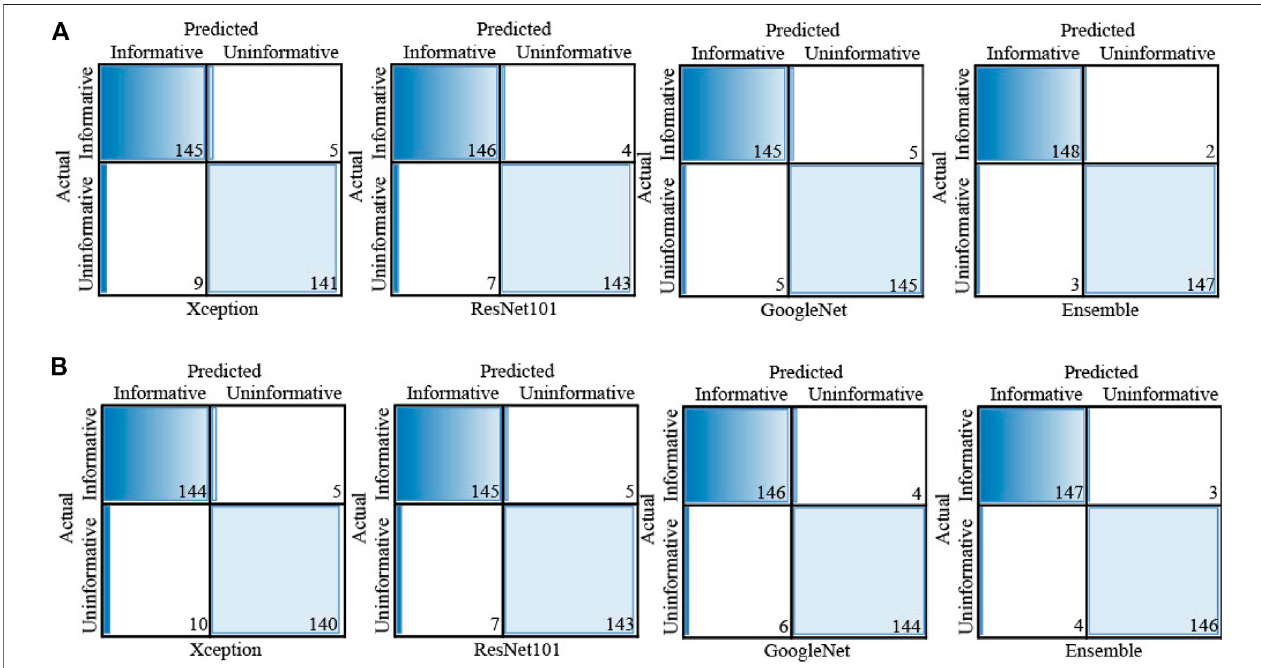
FIGURE 4 | Confusion matrix of each individual classi fi er for (A) informative frame detection and (B) cancerous and noncancerous polyp classi fi cation.